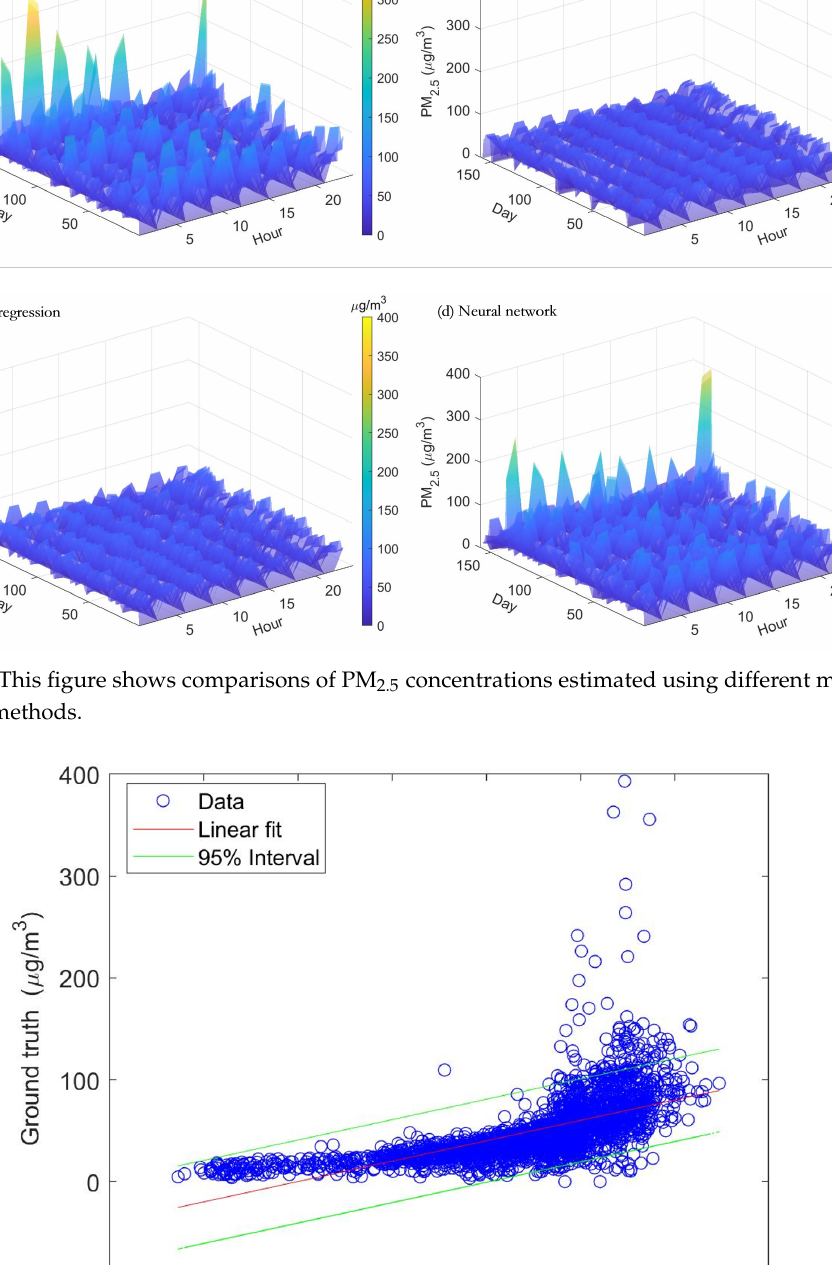
Figure 9. Linear regression lines with red color between estimated PM 2.5 concentrations and the PM 2.5 observation (reference) data. The spaces between the two green lines are the 95% prediction interval. Figure 9. Cont .